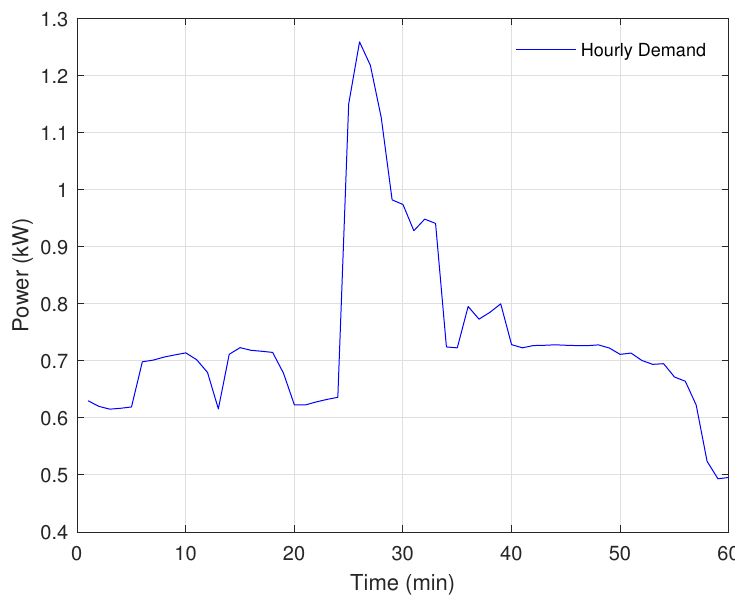
Figure 1. Hourly